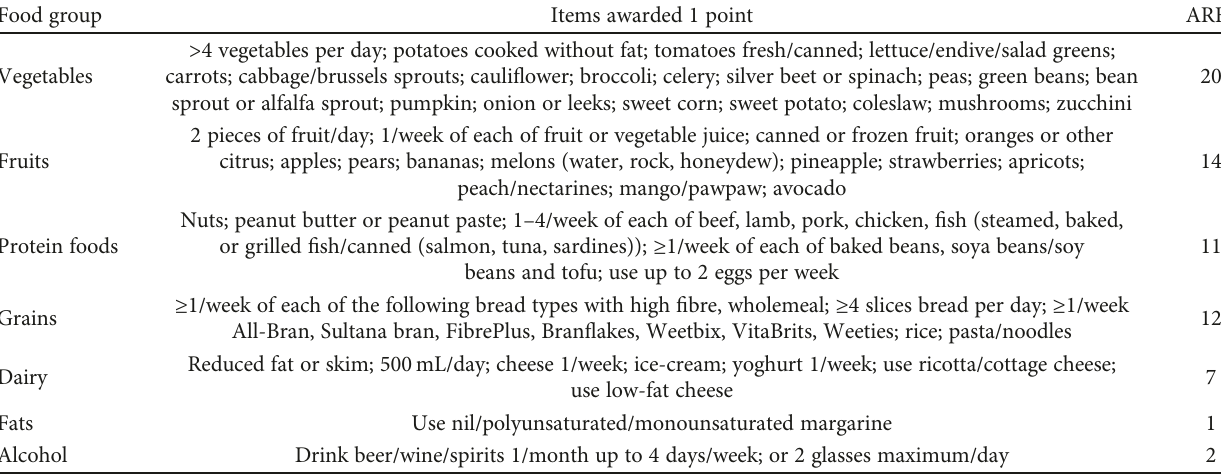
Table 3: Scoring method for foods listed in HCS